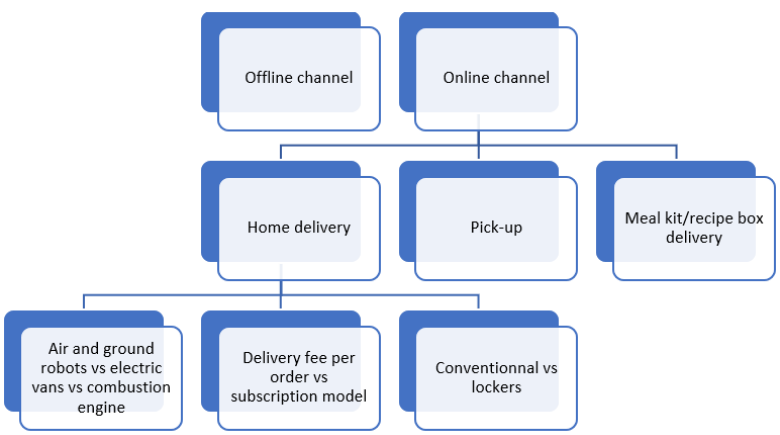
Figure 5. Online channels considered by primary studies .